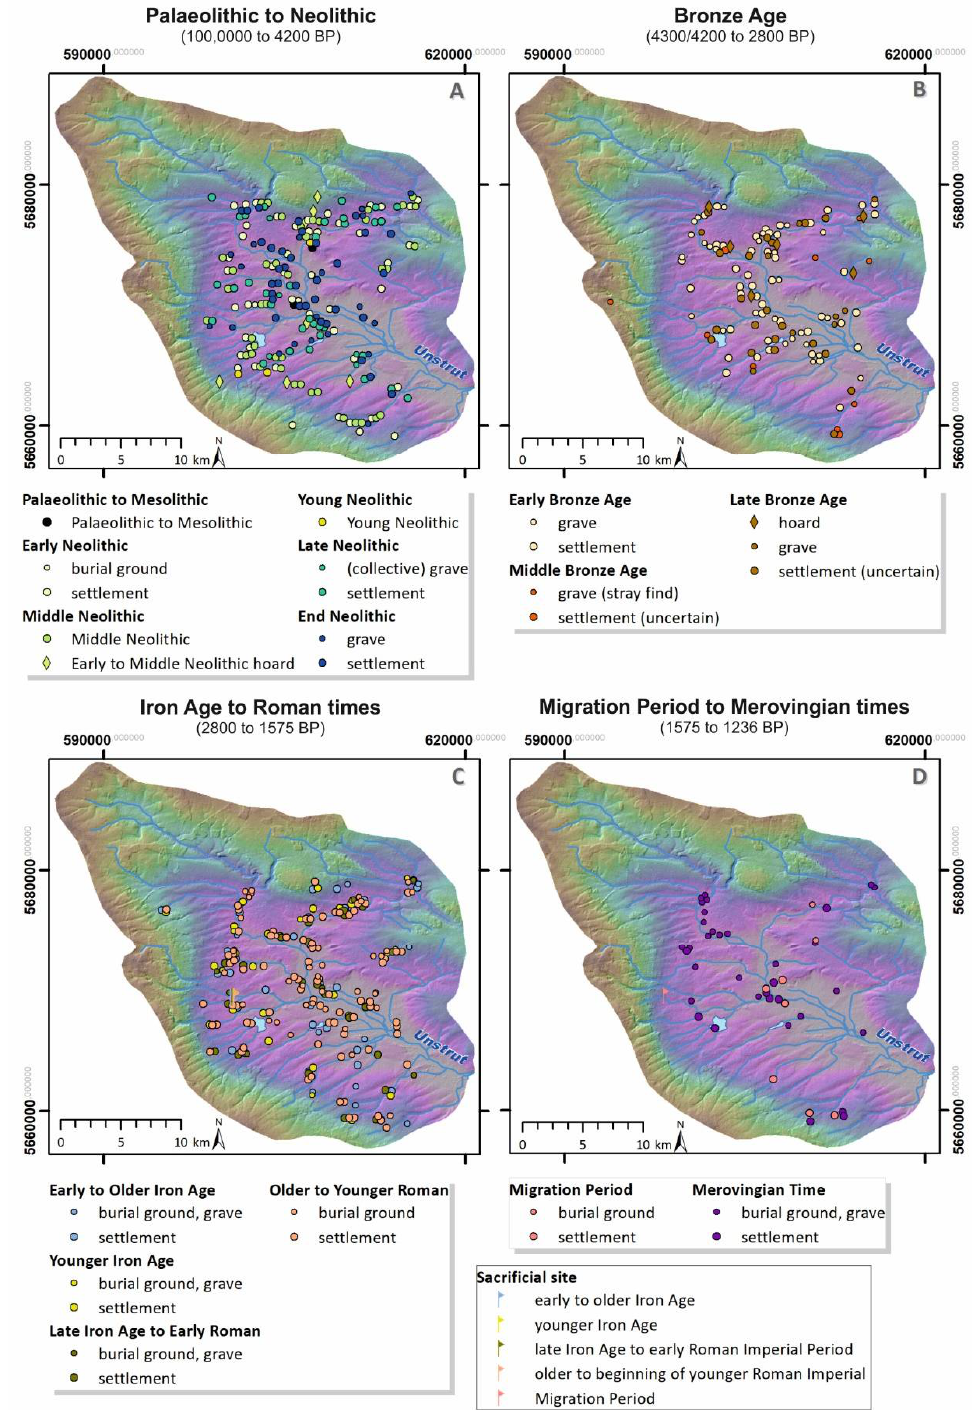
Figure 2. The maps show the upper Unstrut catchment area with 580 known archaeological sites [50] differentiating between ( A ) Palaeolithic to end Neolithic period, ( B ) the Bronze Age, ( C ) early Iron Age to the end of the Roman period, ( D ) the Migration Period to the end of the Merovingian time. Sacrificial sites from the Iron Age onward at the well-known “Opfermoor” were also taken into account [55].